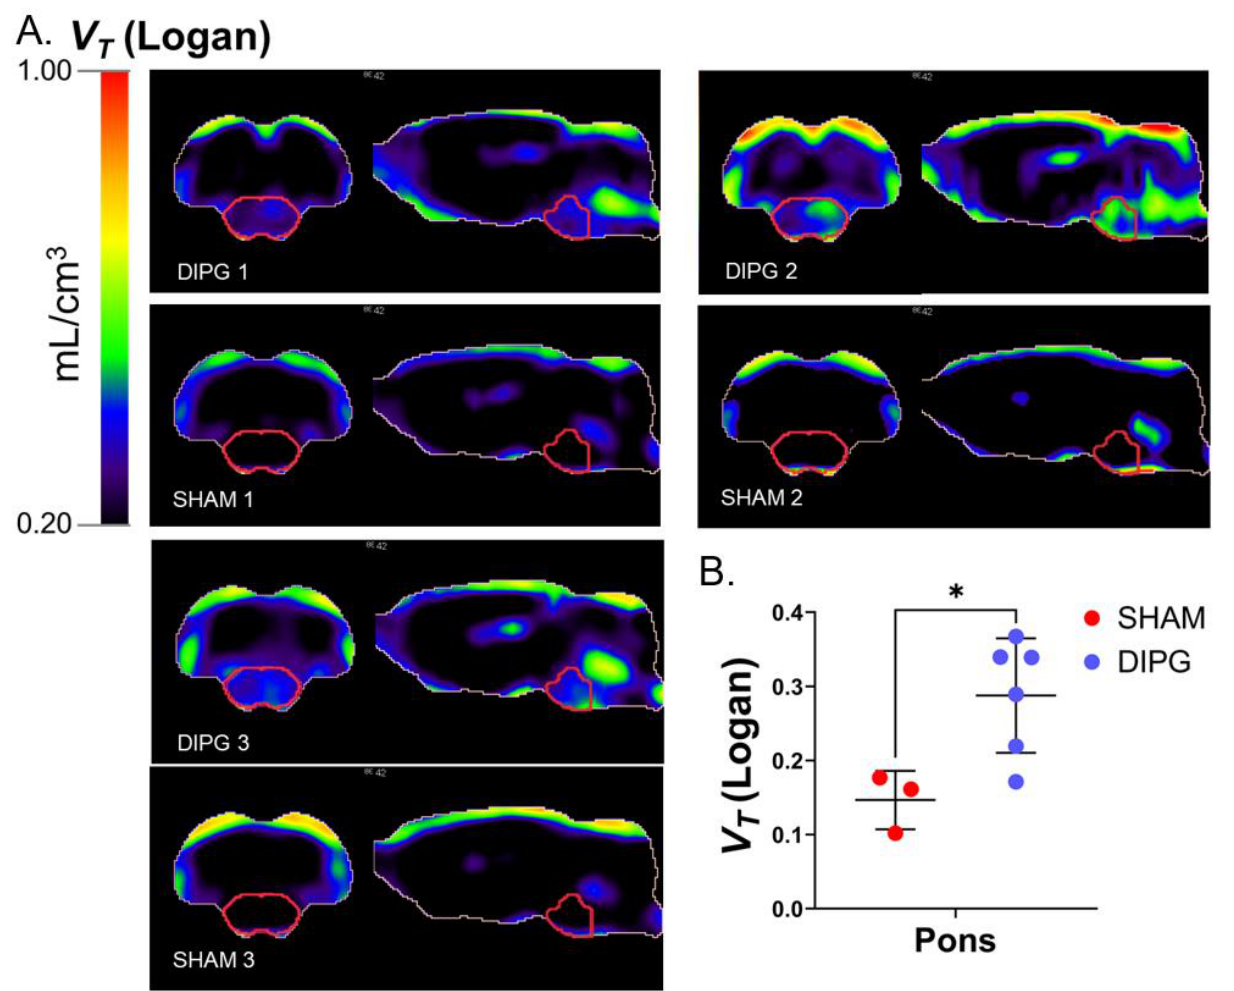
Figure 4. Distribution volume of 18 F-DPA-714. ( A ) Distribution parametric brain images of three sham and tumor-bearing rats. ( B ) Mean distribution volumes of in the pons 18 F-DPA-714. Total volumes of distribution were estimated using the Logan graphical analysis. Statistical significance was determined using t -test with * p < 0.05. Data are represented as mean ± SD.